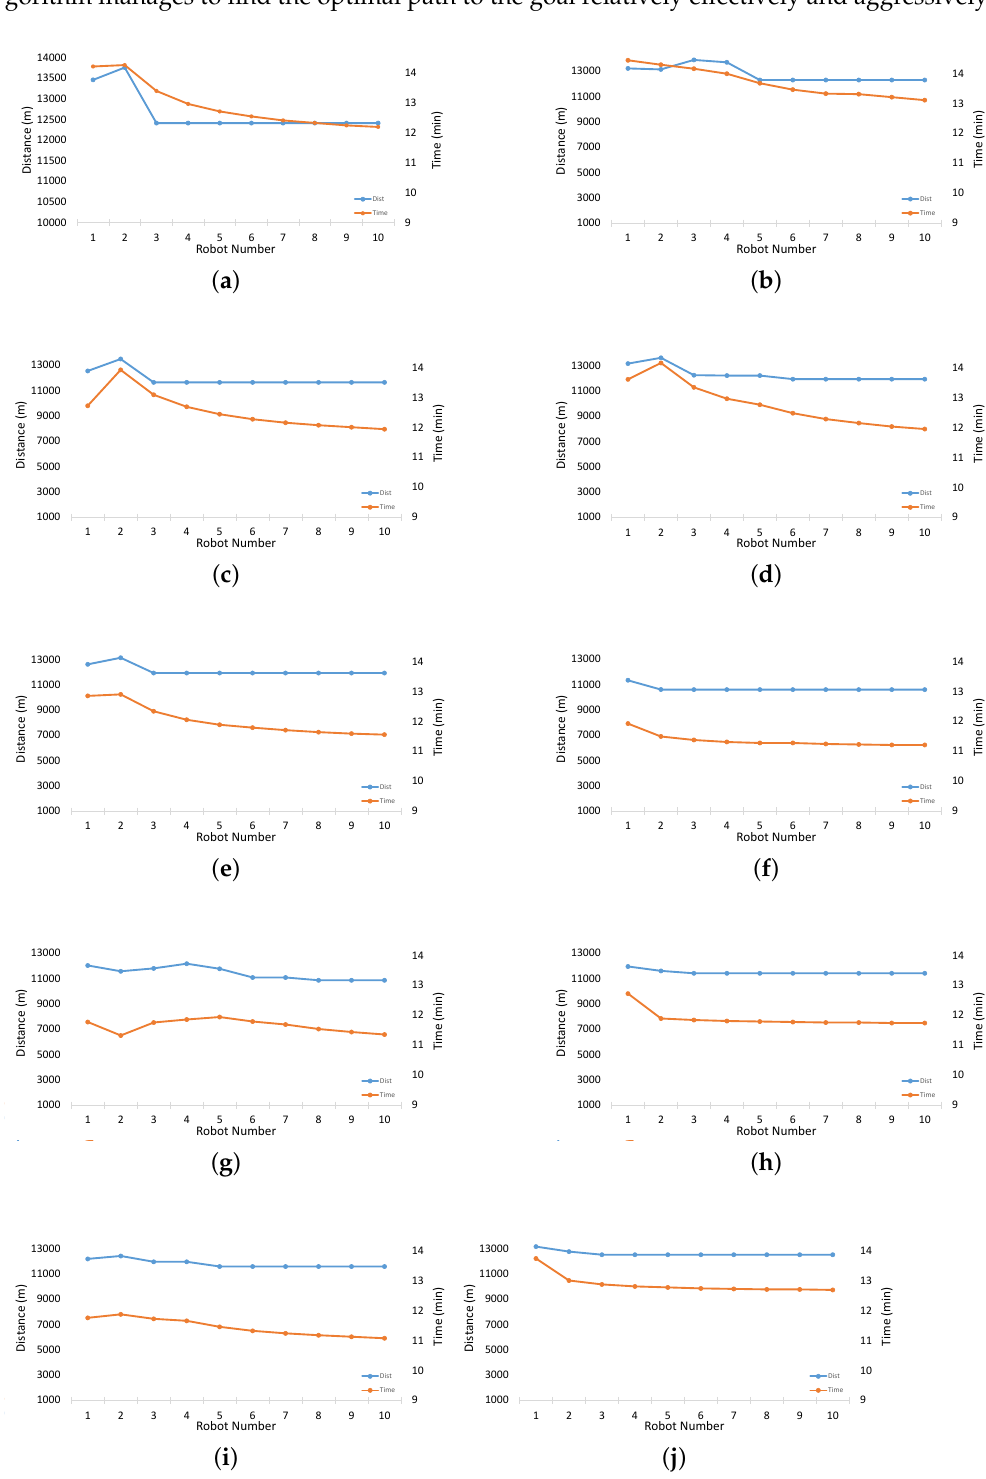
Figure 7. Simulation results: results for respective experiments, showing the total distance traveled by each robot along with the time it took to reach the goal. ( a ) Experimental scenario 1. ( b ) Experimental scenario 2. ( c ) Experimental scenario 3. ( d ) Experimental scenario 4. ( e ) Experimental scenario 5. ( f ) Experimental scenario 6. ( g ) Experimental scenario 7. ( h ) Experimental scenario 8. ( i ) Experimental scenario 9. ( j ) Experimental scenario